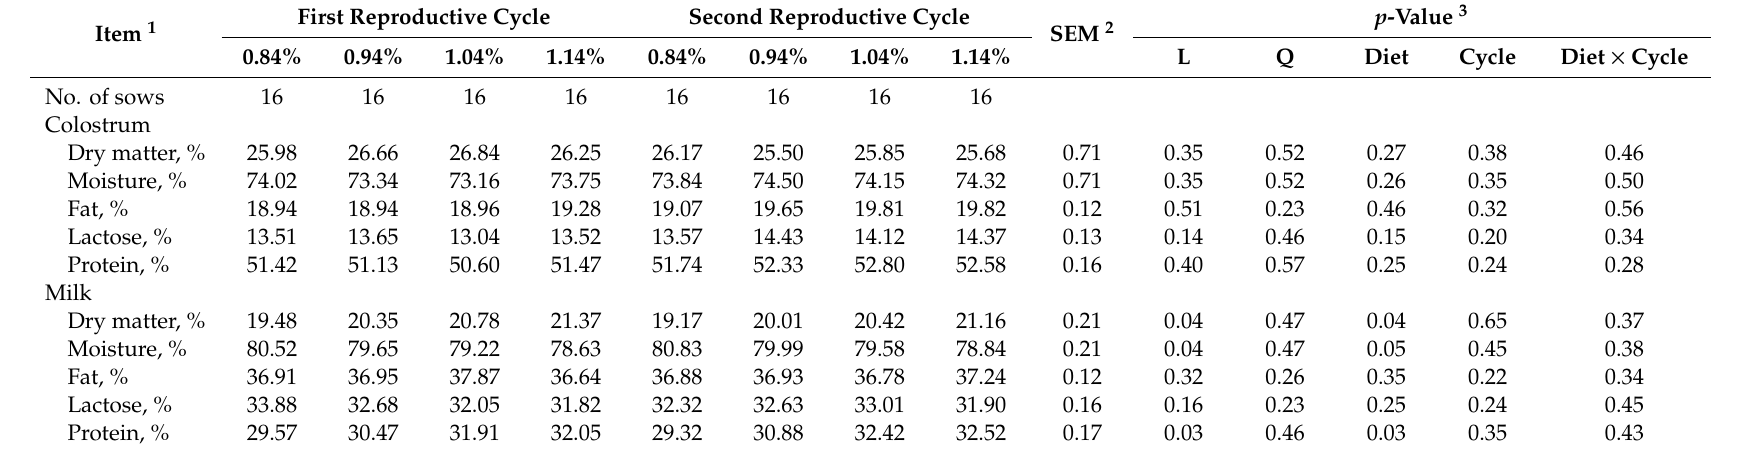
Table 4. E ff ects of di ff erent levels of lysine in lactation diets on the composition of colostrum and milk (dry matter basis).